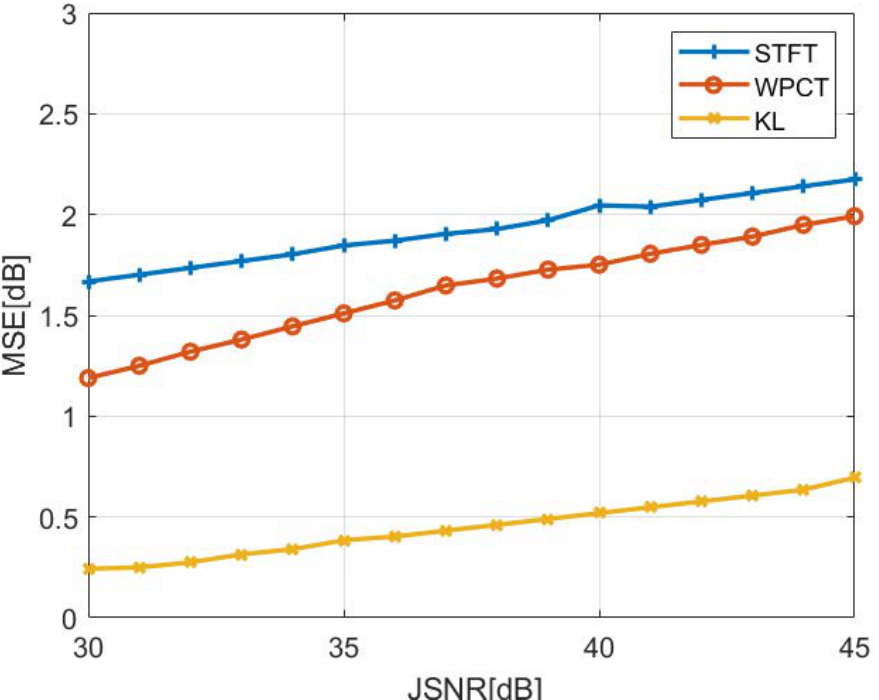
Figure 7. MSE of different interference mitigation algorithms under single-tone